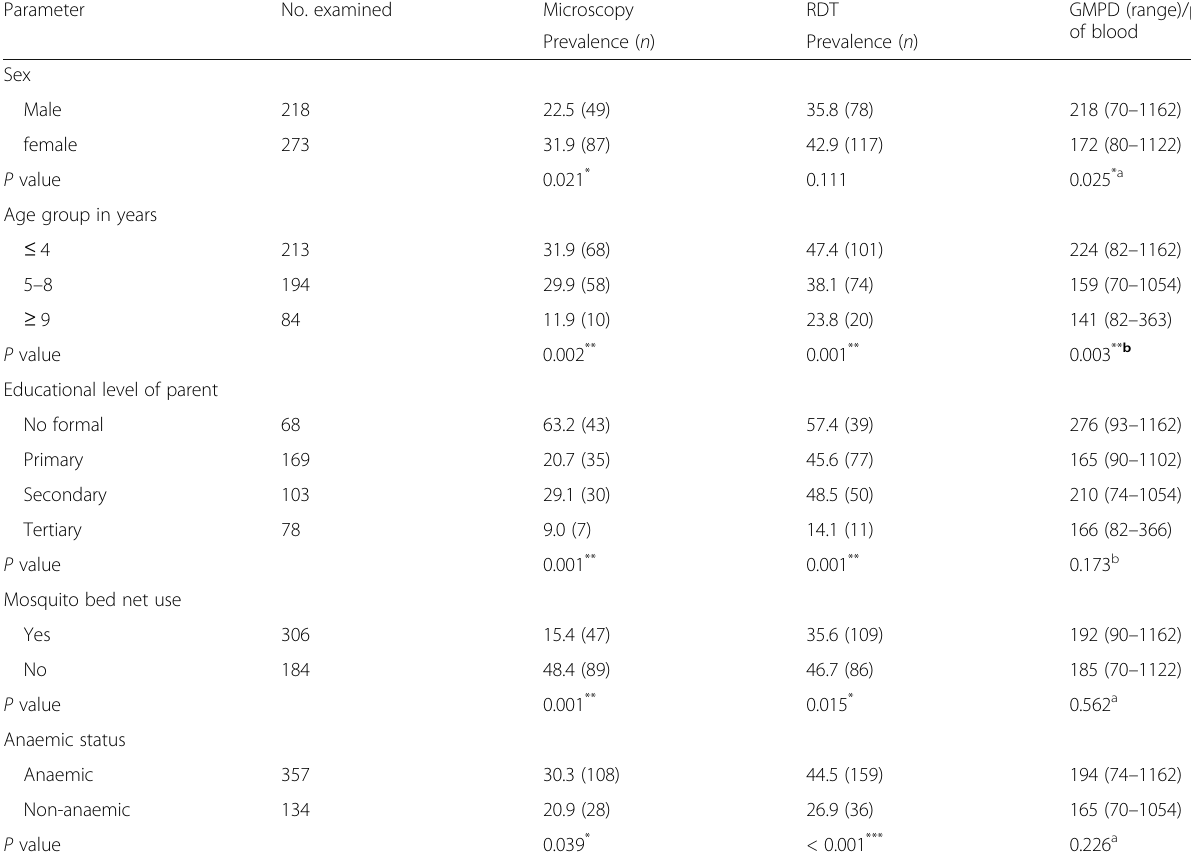
Table 2 Influence of sex, age, educational level of parents, mosquito bed net use and anaemic status on the prevalence of P. falciparum by microscopy and RDT